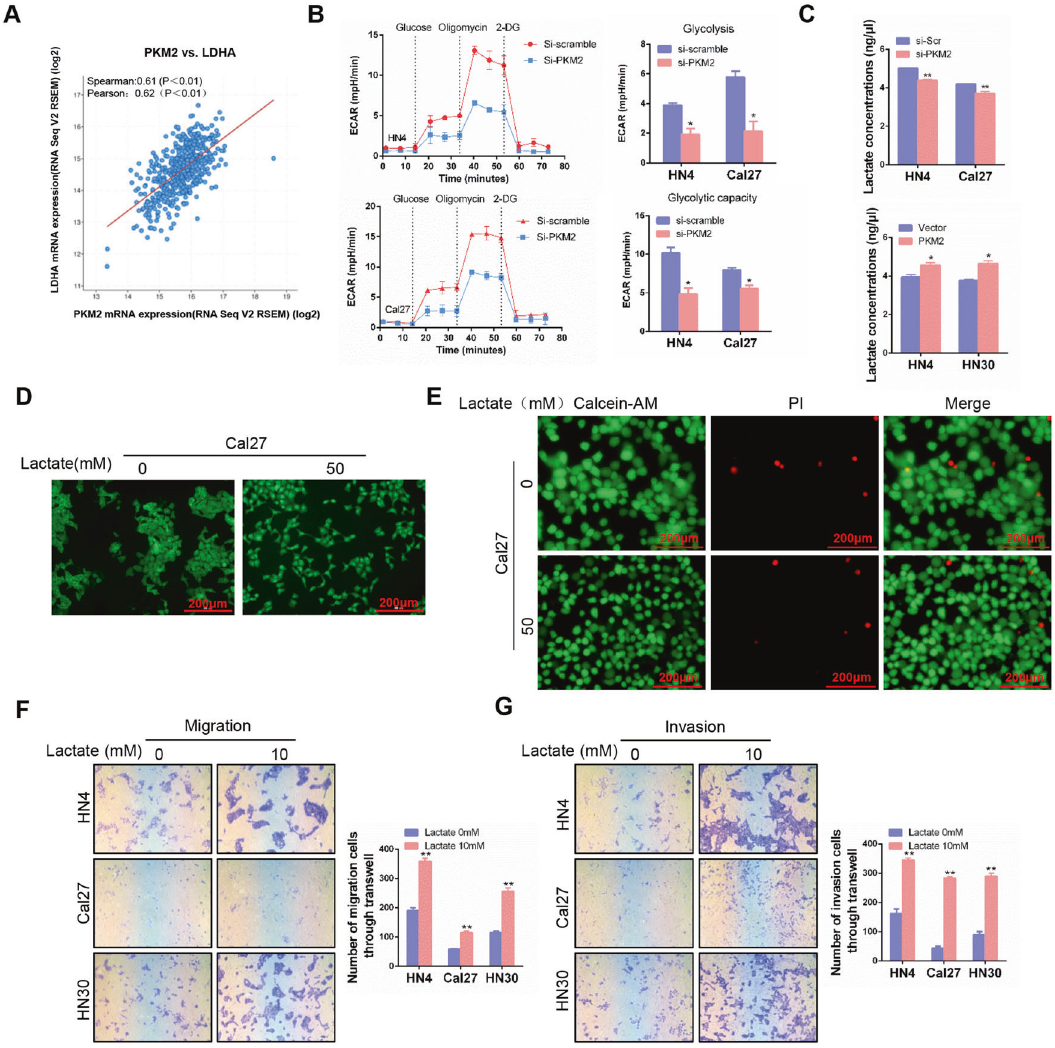
Fig. 4 Lactate released by PKM2 overexpression promotes migration and invasion in HNSCC. A The correlation between PKM2 and LDHA in HNSCC datasets from the TCGA database was analyzed. B The real-time ECAR was analyzed by Seahorse method after PKM2-siRNA transfection for 48 h. c Lactate concentration was detected in medium supernatant after transfection with PKM2 siRNA or PKM2 expression plasmids for 48 h. D The morphology of Cal27 was detected by Actin-Tracker Green after 50 mM lactate stimulation for 24 h. E Live/dead cell staining of was analyzed in Cal27 after treated with 50 mM lactate for 24 h. F , G Migration and invasion assays were performed using the transwell assay after 10 mM lactate treatment for 24 h. bar: 200 μ m * P < 0.05, ** P <